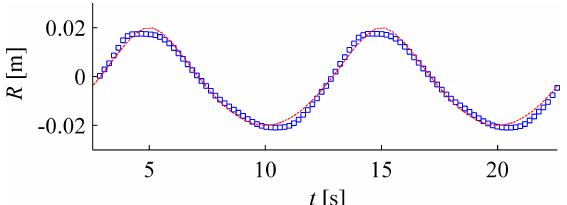
Figure 5. Shoreline vertical motion R of sine wave run-up on a planar beach. Comparison between adopted model (blue dotted lines) and the analytical solution by Carrier and Greenspan [28] (continuous red